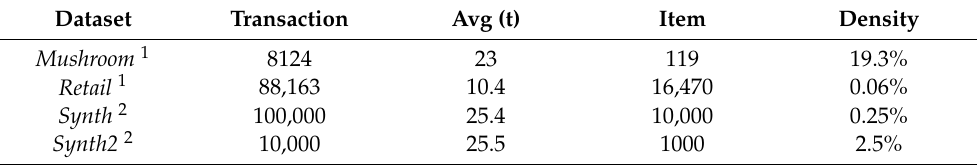
Table 4. Description of public